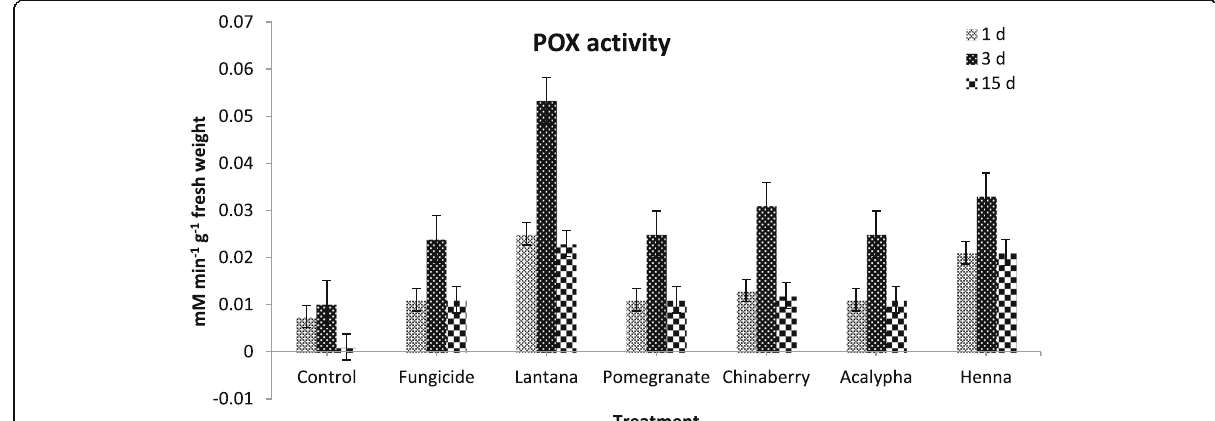
Fig. 3 Effect of some plant extracts on the activity of peroxidase (POX) enzyme in wheat leaves cv. “ Gemmeiza-7 ” infected with Puccinia triticina , as compared to the fungicide Fungshow (diniconazole)